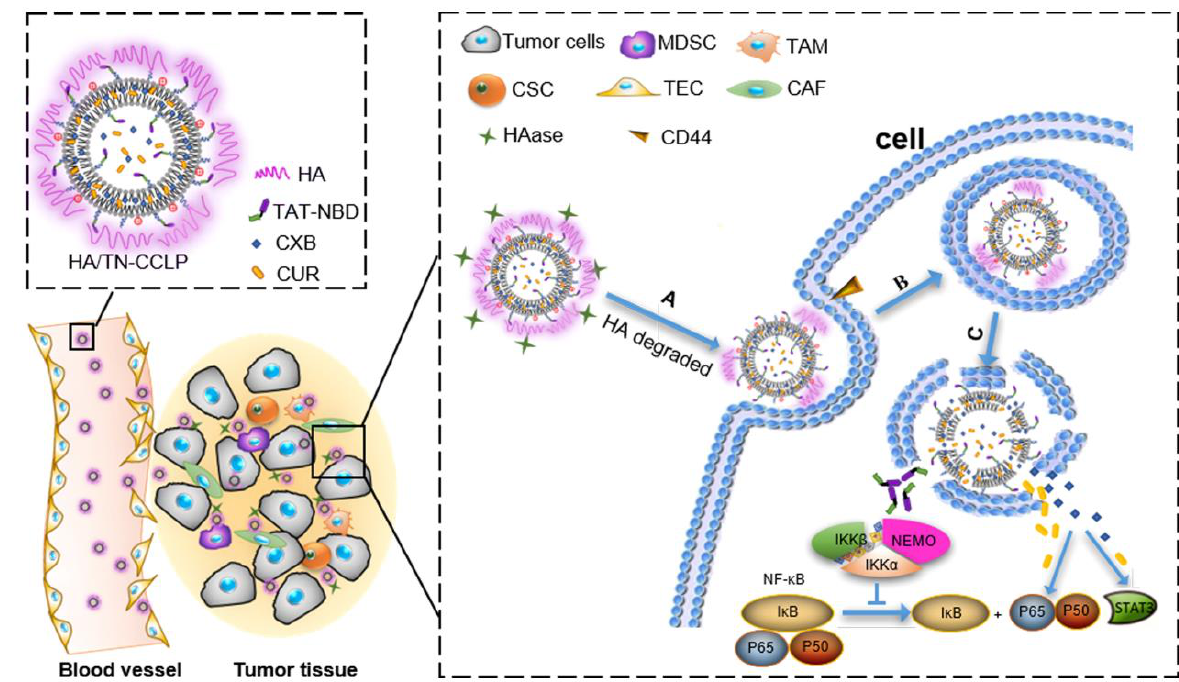
Figure 4. Schematic illustration of the in vivo fate of hyaluronic acid (HA) and TAT-NBD-modified liposomal system (HA/TN-CCLP). After intravenous injection, HA/TN-CCLP preferentially accumulate at the tumor tissues. (A) HA shell degraded or partially degraded by hyaluronidase (HAase), exposed TN-modified cationic liposome, and CD44 receptor promoted cellular uptake; (B, C) Endolysosomal escape. The released celecoxib (CXB), curcumin (CUR), and TAT-NBD peptide (TN) acted on NF- κ B and STAT3. Abbreviations: MDSC—myeloid-derived suppressor cells, TAM—tumor-associated macrophages, CSC—cancer stem cells, TEC—tumor endothelial cells, CAF—cancer-associated fibroblasts. Reprinted with permission from [78]. Copyright 2019 American Chemical Society.